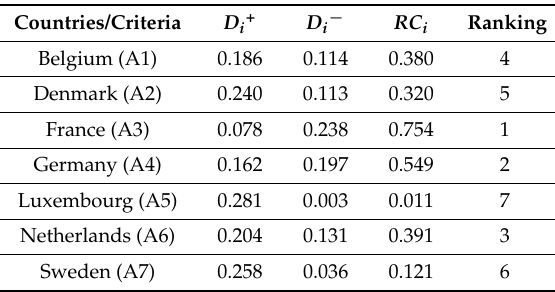
Table 12. The values of weighted criterion matrix.